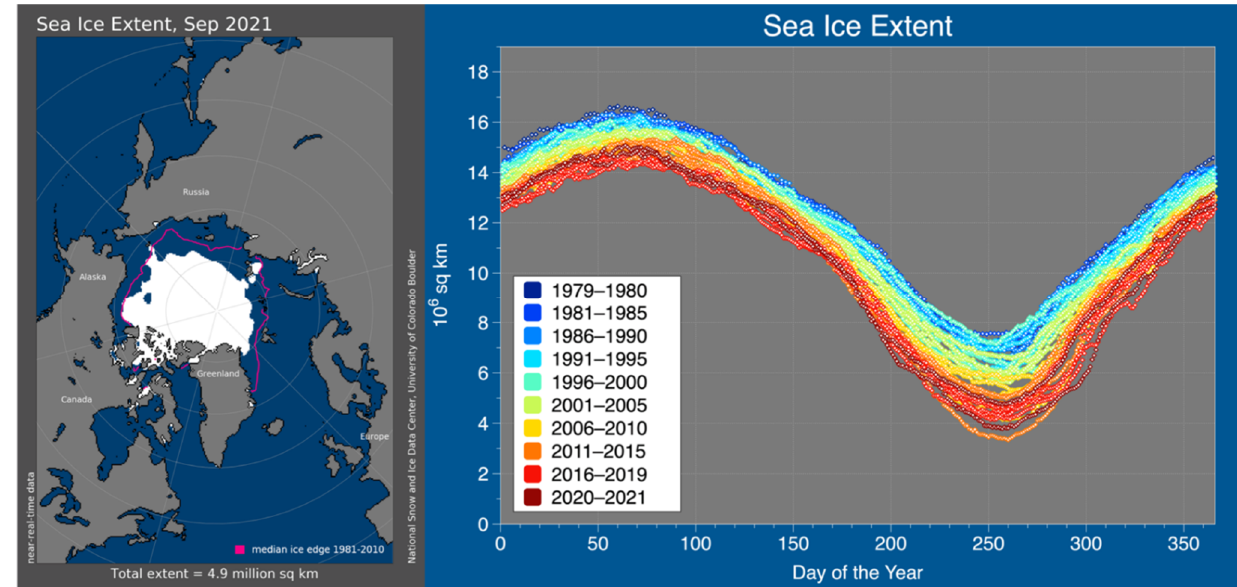
Figure 1. Left panel: sea ice extent (greater than 15% concentration) for the September mean compared with 2020 with record low 2012. Right: seasonal cycle of the daily Arctic sea ice extent in millions of square kilometers. Recent decades display sea ice decline in all months of the year. The left panel, and data for the right panel, is courtesy of the National Snow and Ice Data Center, University of Colorado, Boulder. The right panel graphic is modified from a DataGraph template.